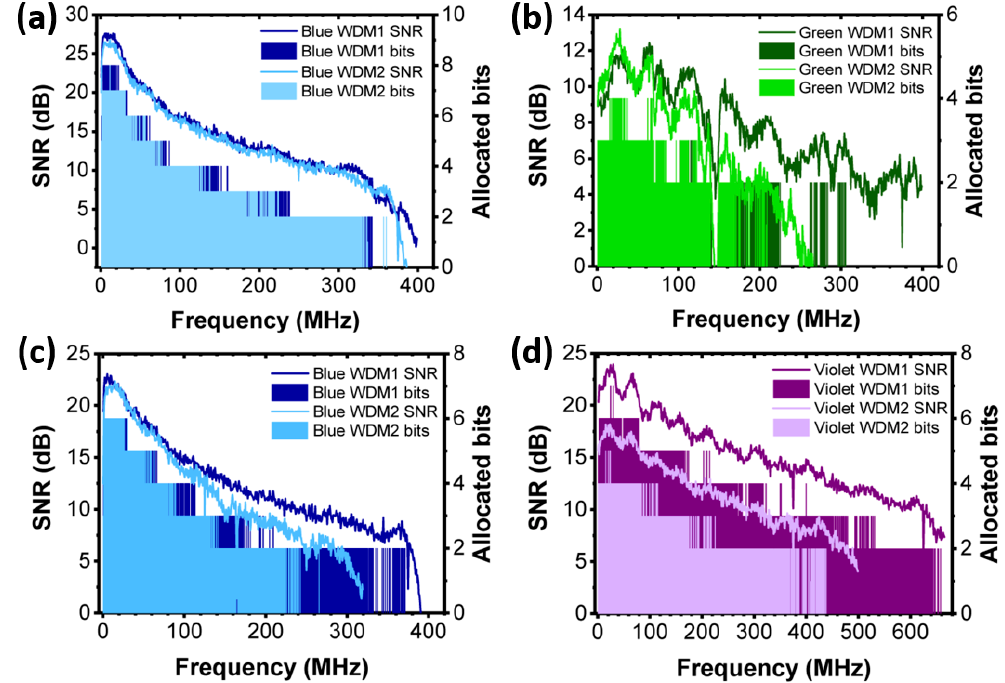
Figure 8. For the blue-green µ-LED array: signal-to-noise ratio and allocated bits plots in both WDM schemes attained by ( a ) the blue µ-LED and ( b ) the green µ-LED; for the blue-violet µ-LED array: signal-to-noise ratio and allocated bits plots in both WDM schemes attained by ( c ) the blue µ-LED and ( d ) the violet µ-LED. [77] Figures reproduced with permission from Optical Society of America.